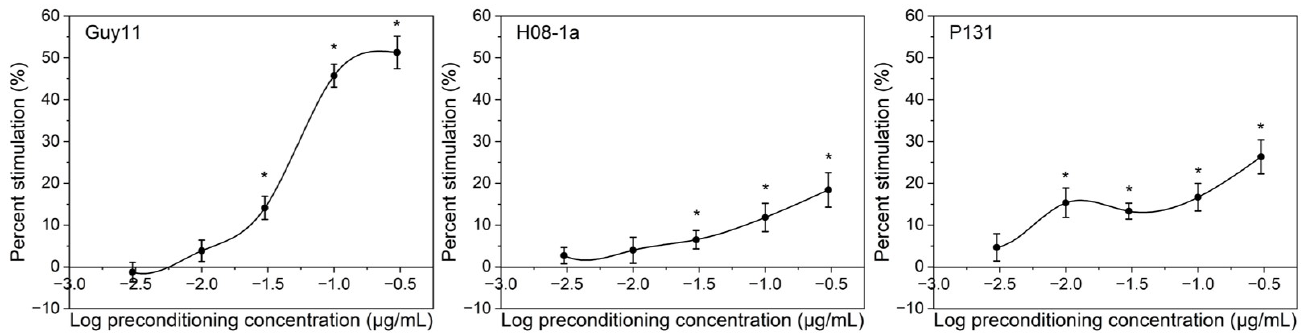
Figure 3. Stimulatory effects of carbendazim pretreatment on the sixth-generation mycelial growth of Magnaporthe oryzae grown on PDA supplemented with carbendazim at 0.3 µ g/mL. Error bars represent the standard errors of mean values in independent experiments. Asterisk indicates significant difference ( p < 0.05) between the treatment and the control without pretreatment.